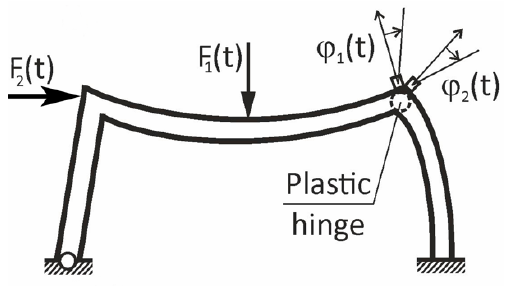
Figure 5. Variations of rotations of the bar ends in a frame corner, as indicators of the early stage of plastic hinge formation.